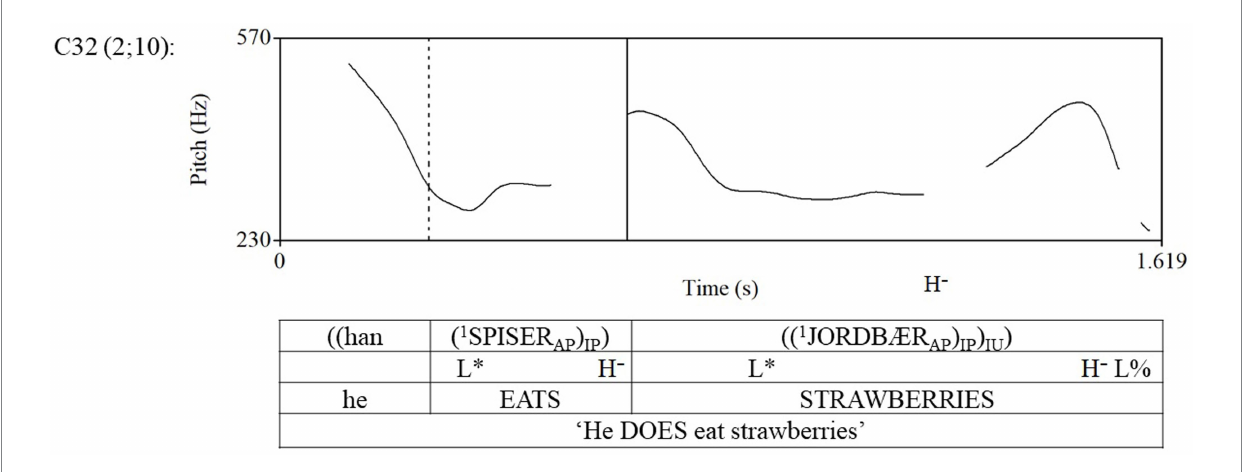
FIGURE 3 PF production by 2-year-old in the Pos-Aff